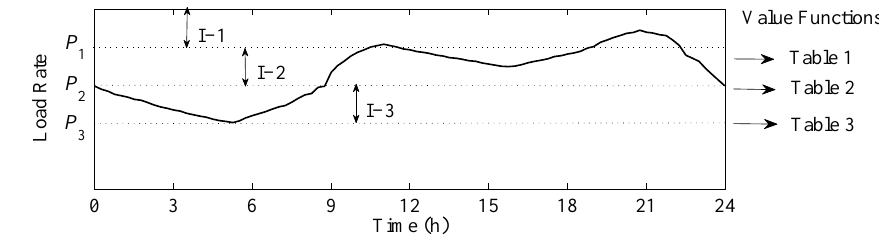
Figure 3. Mapping from intervals to parallel tables.